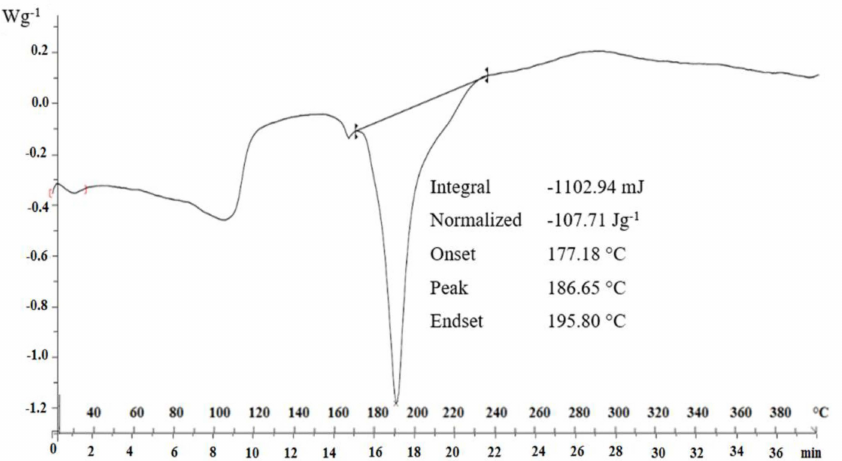
Figure 11. DSC curve for products crystallized from NO x gases in Test B.